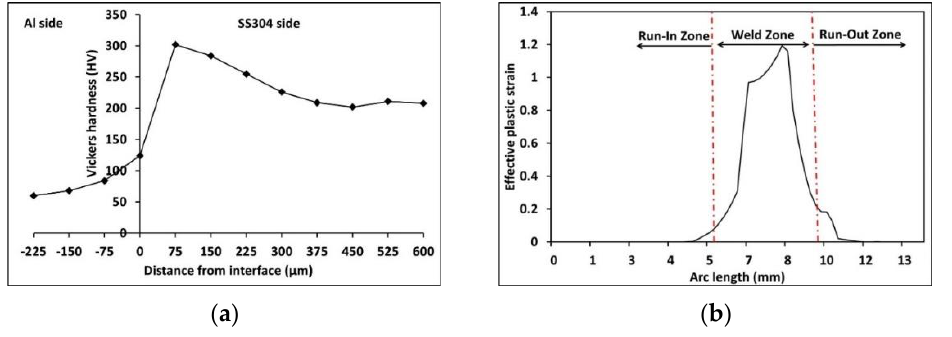
Figure 9. ( a ) Hardness and ( b ) plastic strain at the weld interface.